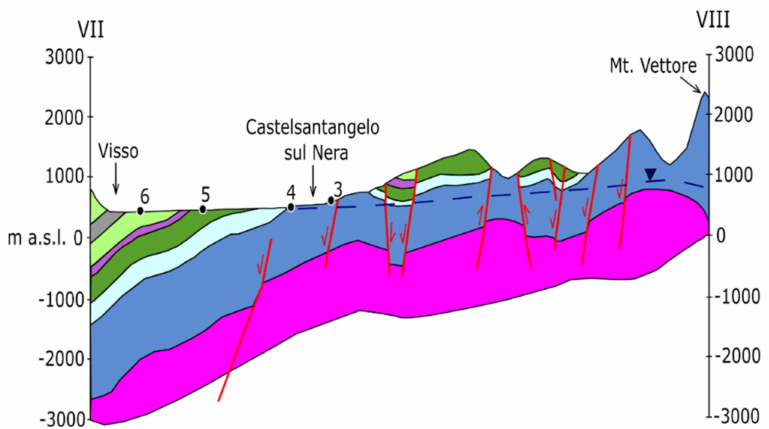
Figure 11. Hydrogeological cross-section (SE-NW oriented) modified from [37] with the hypothetic elevation of water table and the monitoring points along the Castelsantangelo stream. The vertical scale is exaggerated to better visualize the piezometric gradient, the colors in section refers to the sketch of hydrogeological complexes reported in Figure